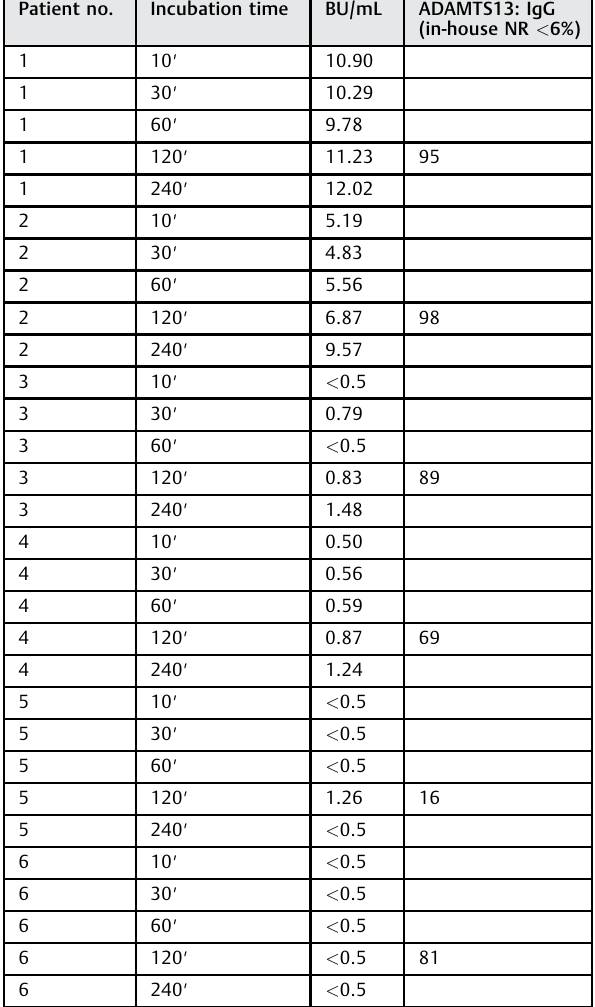
Table 1 Analysis of anti-ADAMTS13 antibodies with Bethesda assay and ELISA in six patients with immune-mediated TTP Patient no.